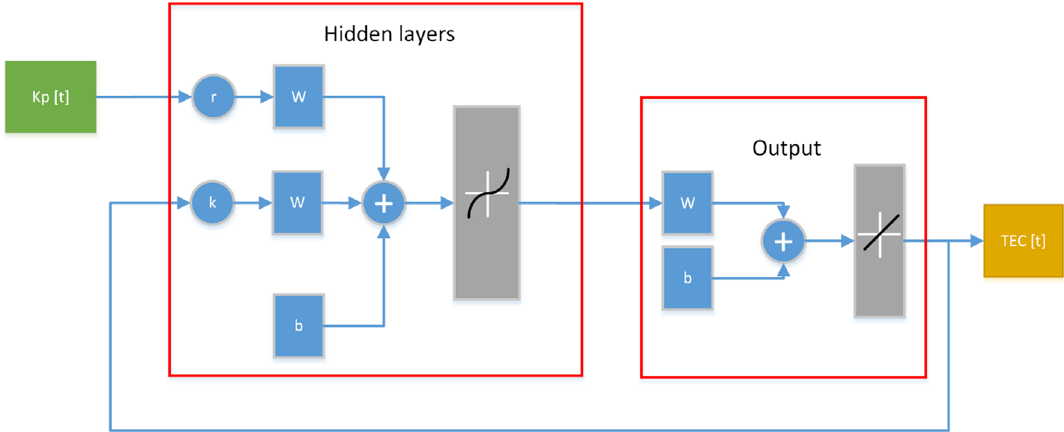
Fig. 4. Block diagram of the trained neural network (parallel architecture).